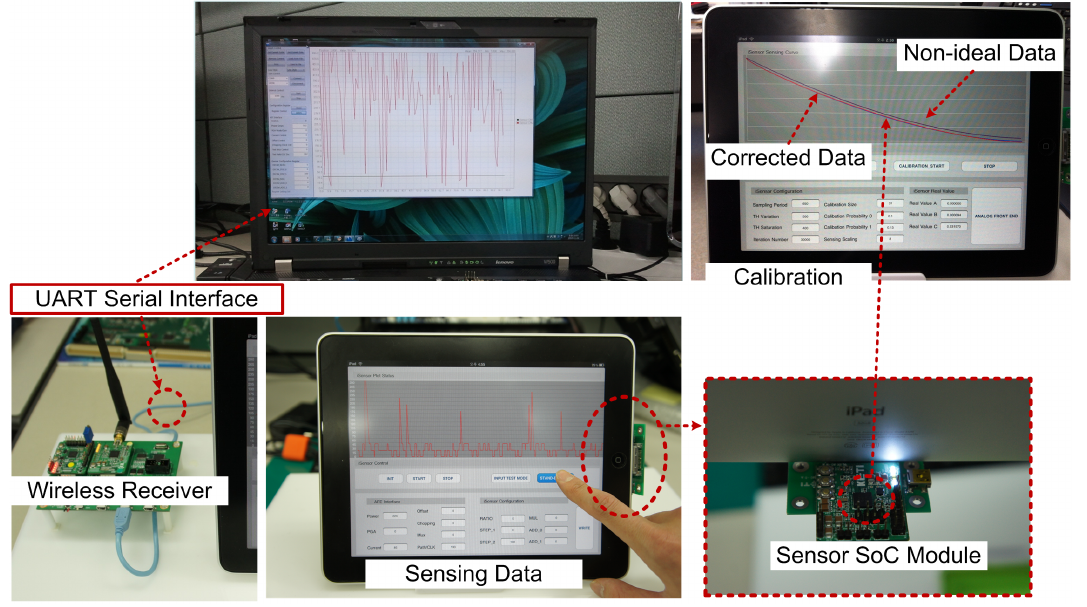
Figure 13. Verification with prototype sensor